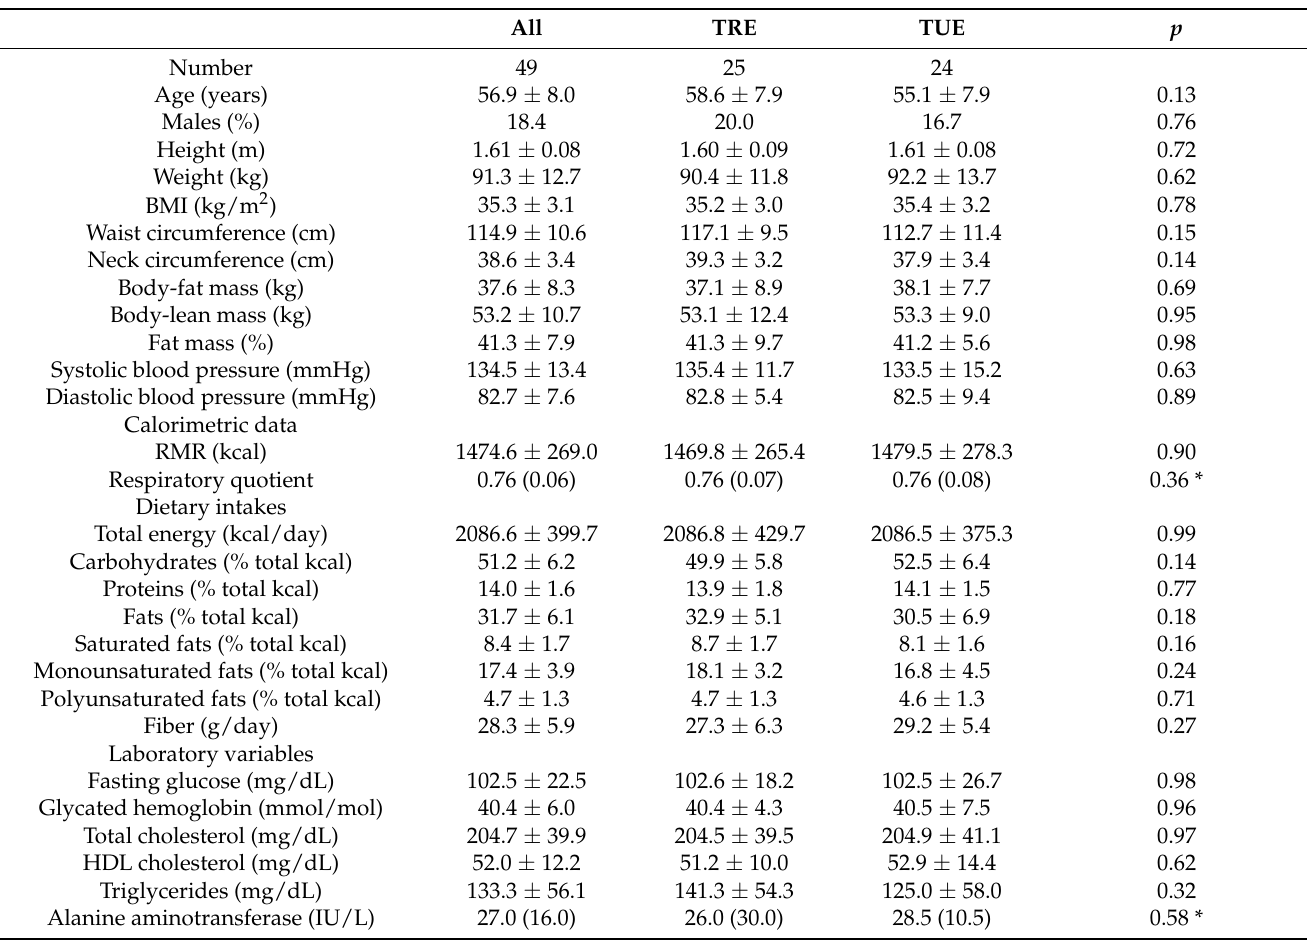
Table 1. Baseline characteristics by dietary